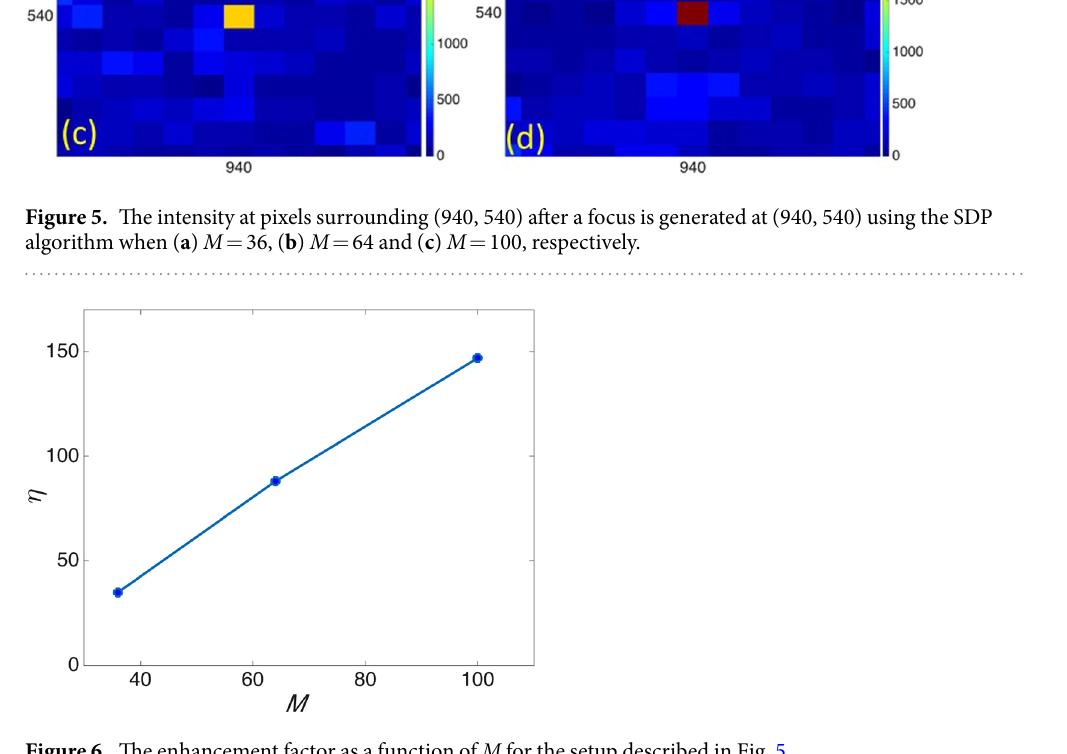
Figure 6. The enhancement factor as a function of M for the setup described in Fig.